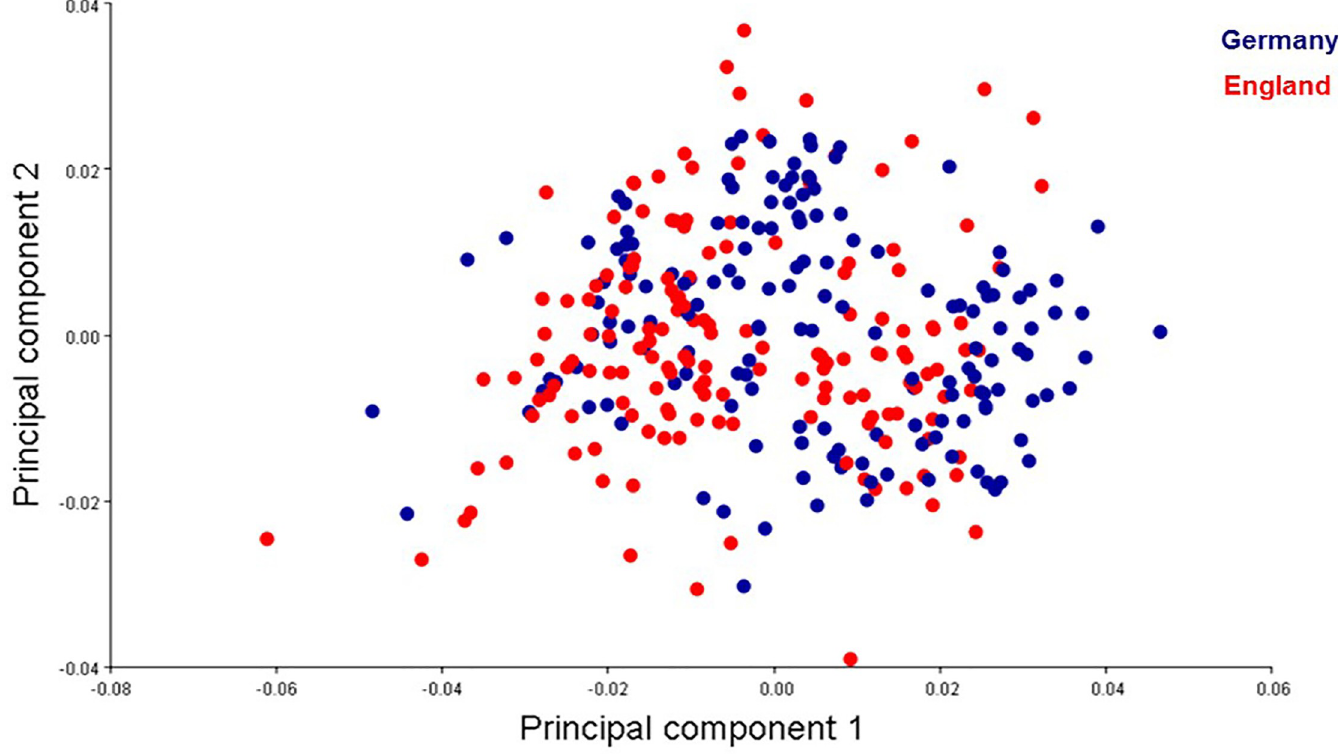
Fig 5. Projections of Procrustes-aligned landmark configurations on the first two principle components of the shape covariance matrix of C . vicina from Germany and